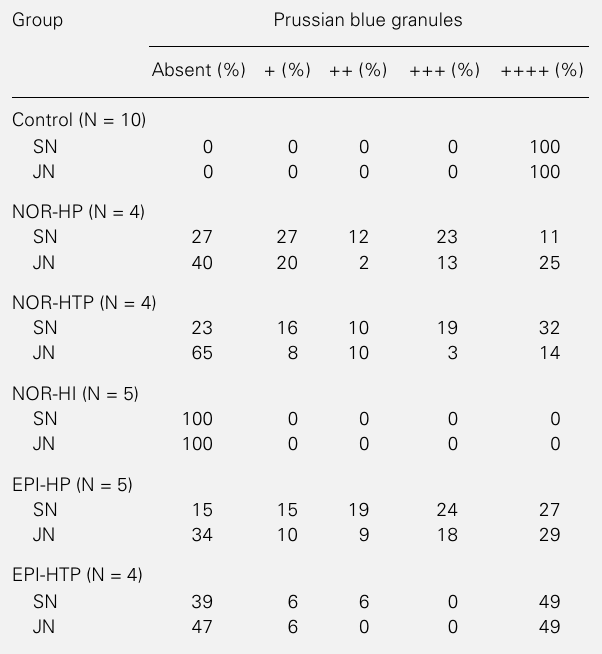
Table 2 - Number of Prussian blue granules in the glomeruli of superficial nephrons (SN) and juxtamedullary nephrons (JN) in the control group and in the subgroups of rats treated with norepineph- rine (NOR) and epinephrine (EPI), showing a homogeneously (HP) and heterogeneously (HTP) perfused and homogeneously ischemic (HI) pattern.